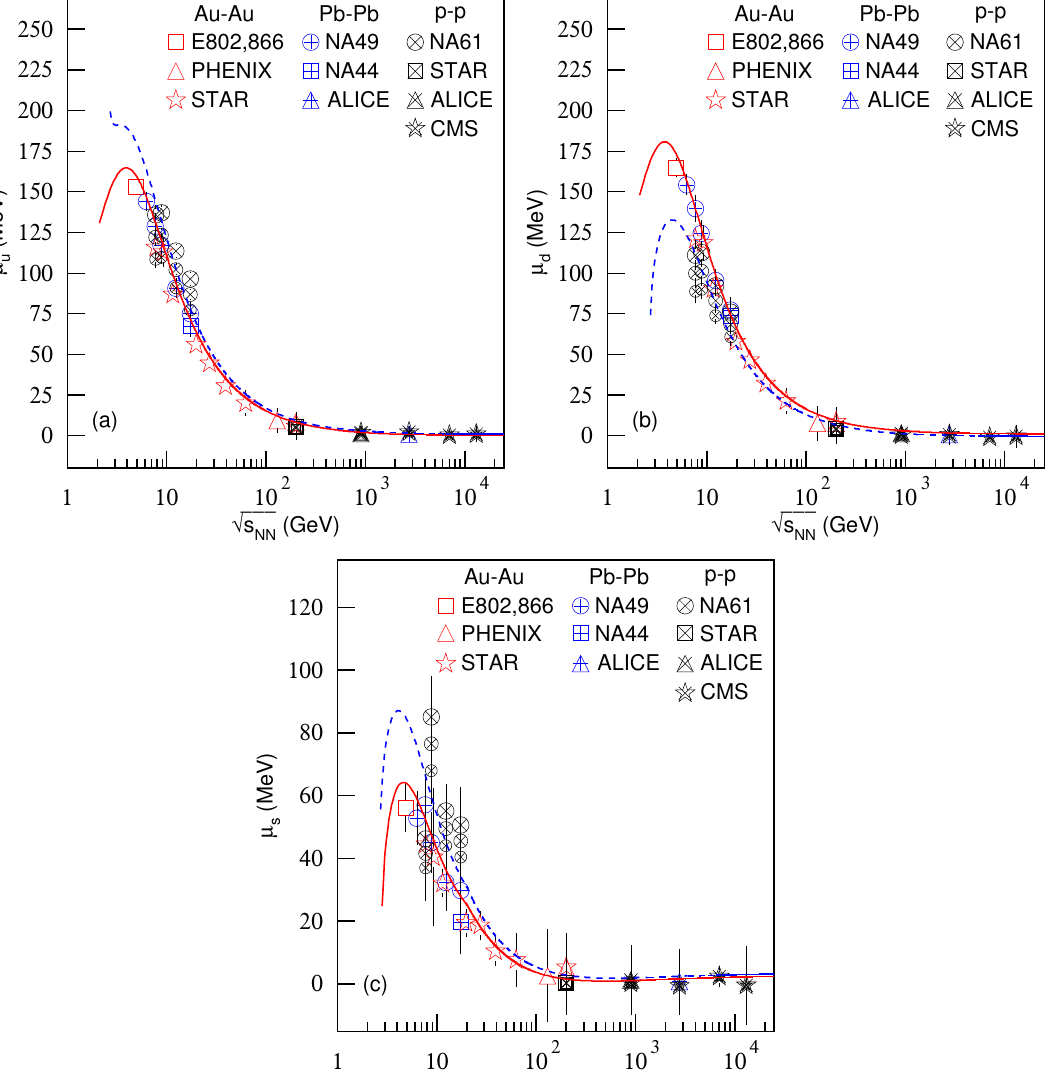
Figure 3. Chemical potentials: ( a ) µ u ; ( b ) µ d ; and ( c ) µ s , of ( a ) u ; ( b ) d ; and ( c ) s quarks derived from mid-rapidity interval (in most cases) in central Au–Au (Pb–Pb) and INEL or NSD pp collisions at high energies. The symbols denote the derivative data obtained from Figure 1 according to Equation (6). In particular, the NA61/SHINE data appear in the forward rapidity region (in the center-of-mass system), although the experiment can provide results with 4 π geometry. The normal, medium, and small symbols with diagonal crosses denote the derivative data in INEL or NSD pp collisions obtained by T ch , 0.9 T ch , and 0.8 T ch in Equation (6), respectively. The curves surrounding the symbols are the derivative results obtained from the curves in Figure 1 according to Equation